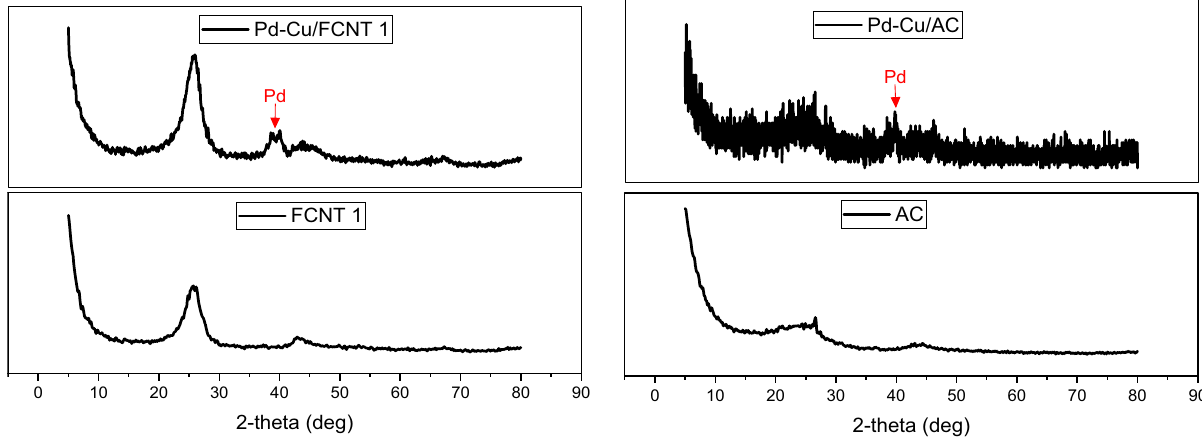
Figure 3: XRD patterns of FCNT1 and 4Pd – 1Cu/FCNT1.